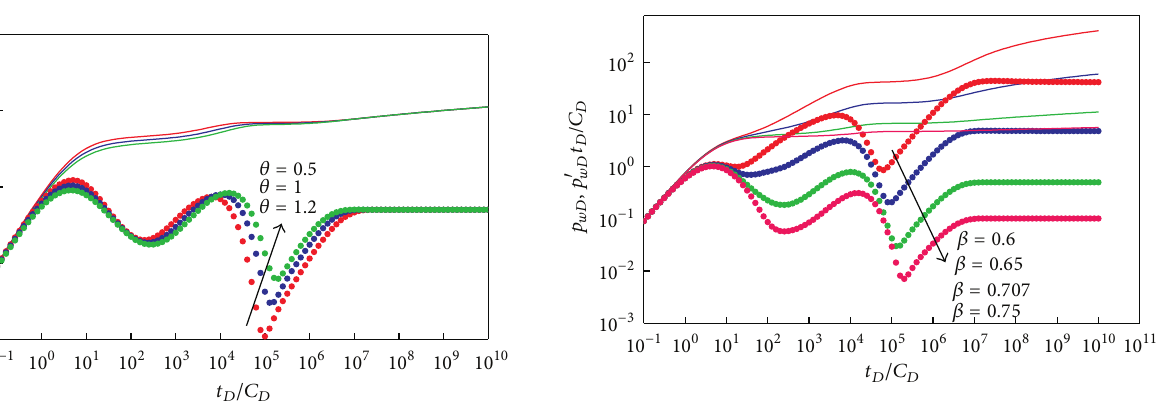
= 10 m, 𝑑 = 0.05 m, 𝐷 = 1.5 , 𝑇 = 4 , 𝑟 = 0 0 𝑓 𝑚 𝑤 = 0.0001 , ℎ = 10 m, 𝐶 = 2.2 × 10 −5 MPa −1 , and 𝐷𝑒 𝑚𝑡